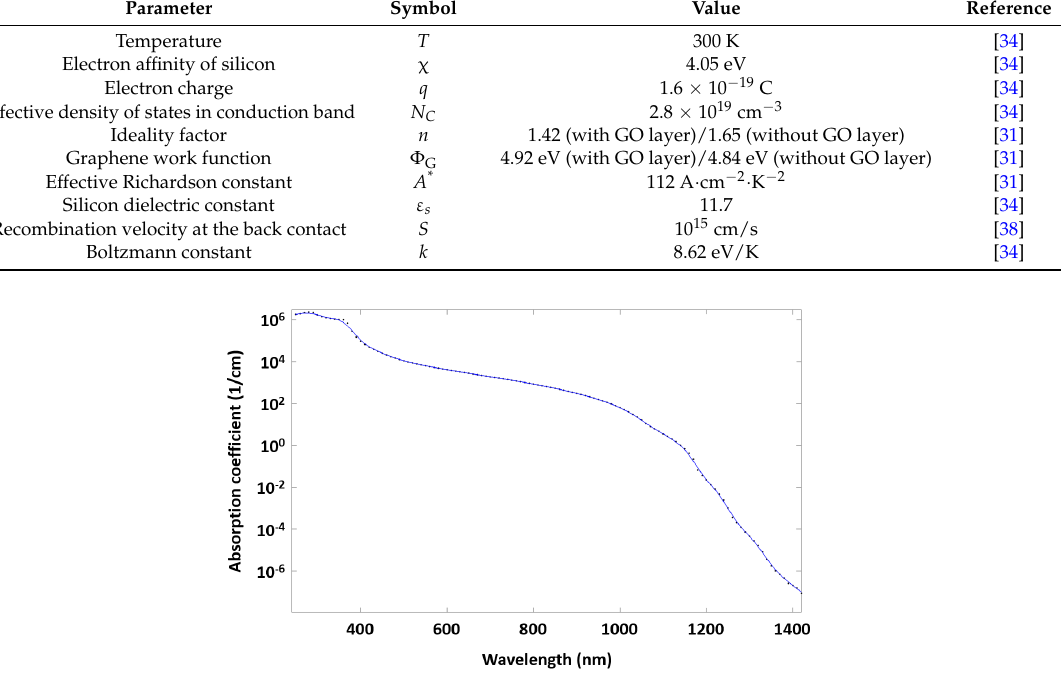
Figure 3. Wavelength-dependent silicon absorption coefficient.